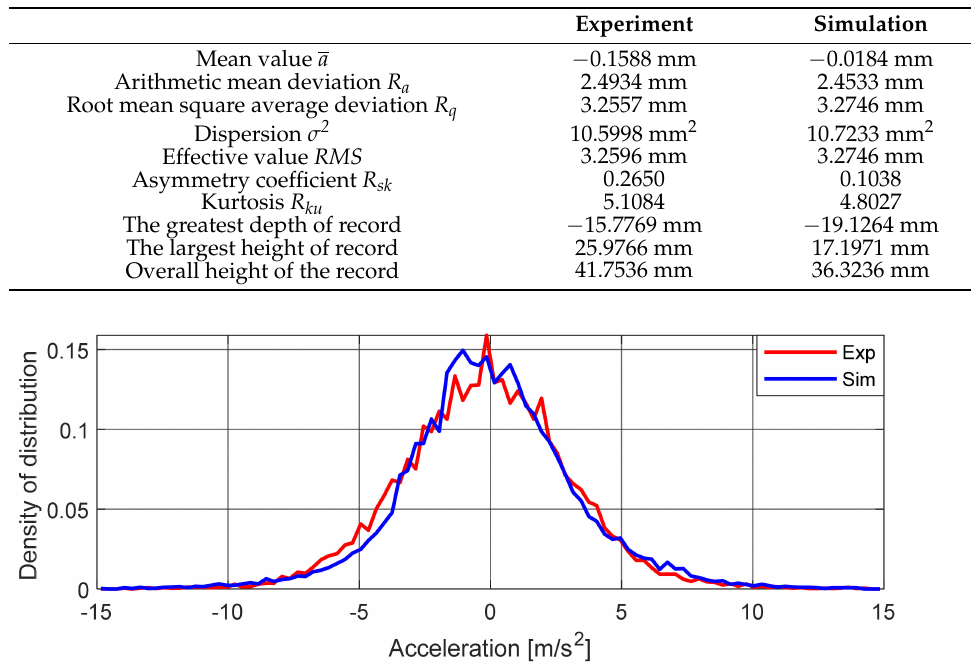
Table 7. Statistical characteristics of acceleration on vehicle RA.